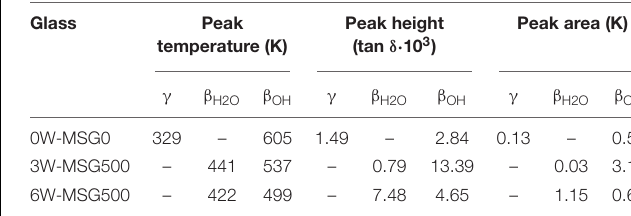
TABLE 2 | Parameters of DMA peak